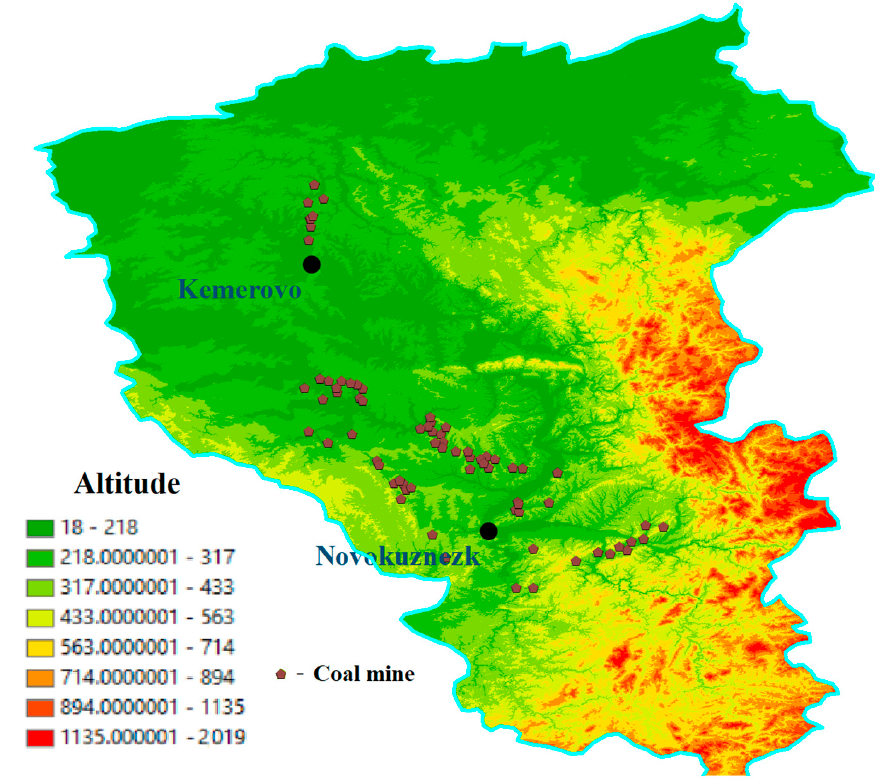
Figure 2. Kemerovo region, Russia with coal mines indicated.